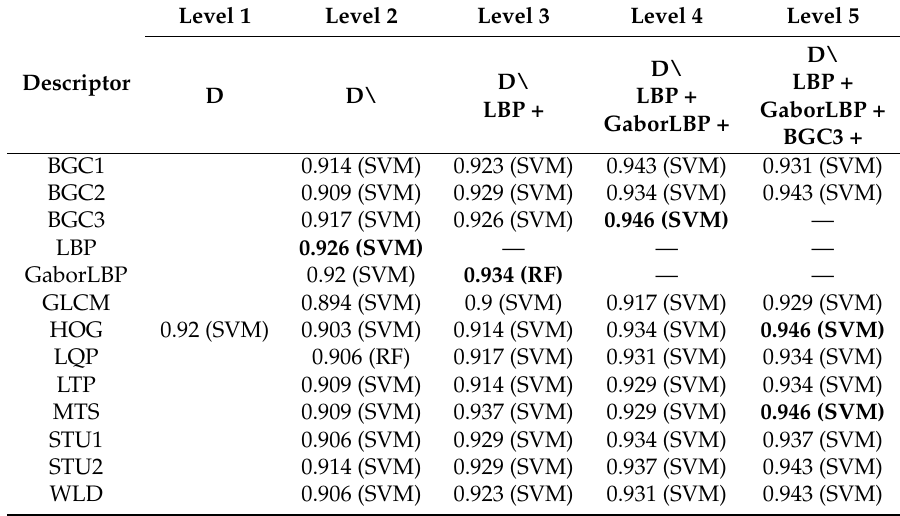
Table 6. Backward Subset Selection of descriptors applied to 8 × 8 gridded image (also known as BSS 8 × 8).